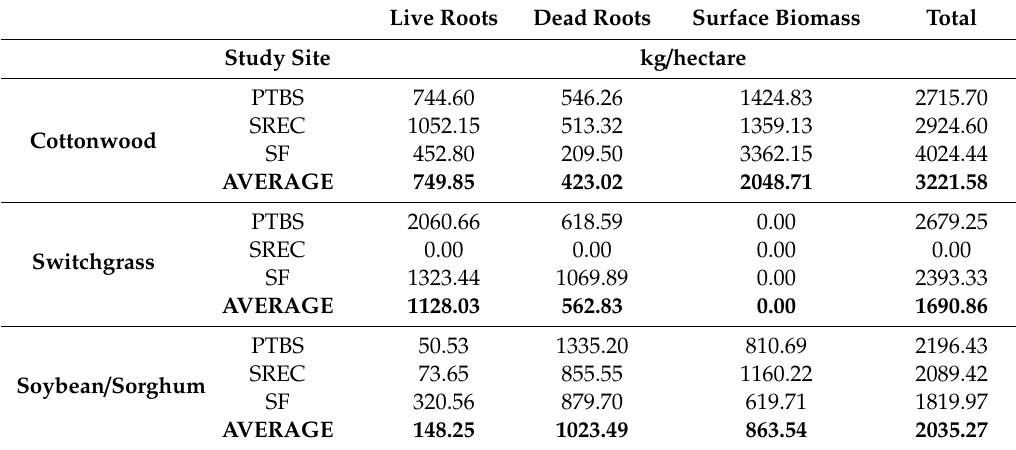
Table 4. Carbon (kg C ha − 1 ) sequestration on site by live roots, dead roots, and surface biomass as residue (not harvestable tree biomass) after the first three years.